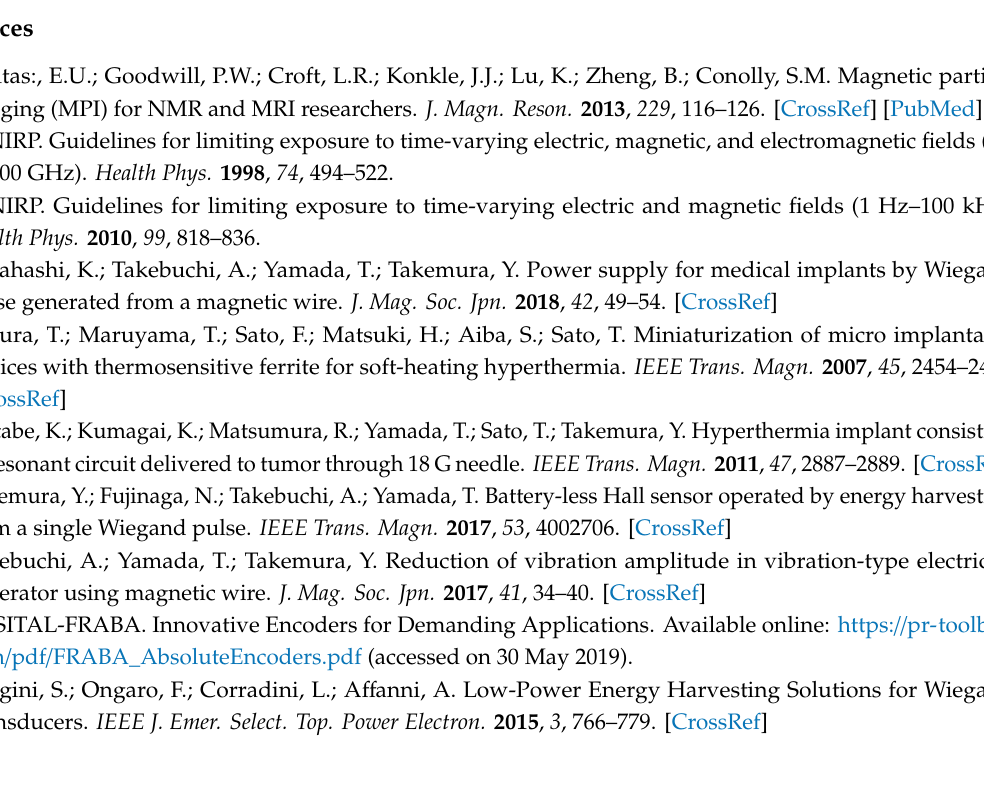
Figure 12. Application of an AC current of small amplitude where a large Barkhausen jump occurs due to the independent magnetic field of the slow-moving magnet shown in the circuit of Figure 3.